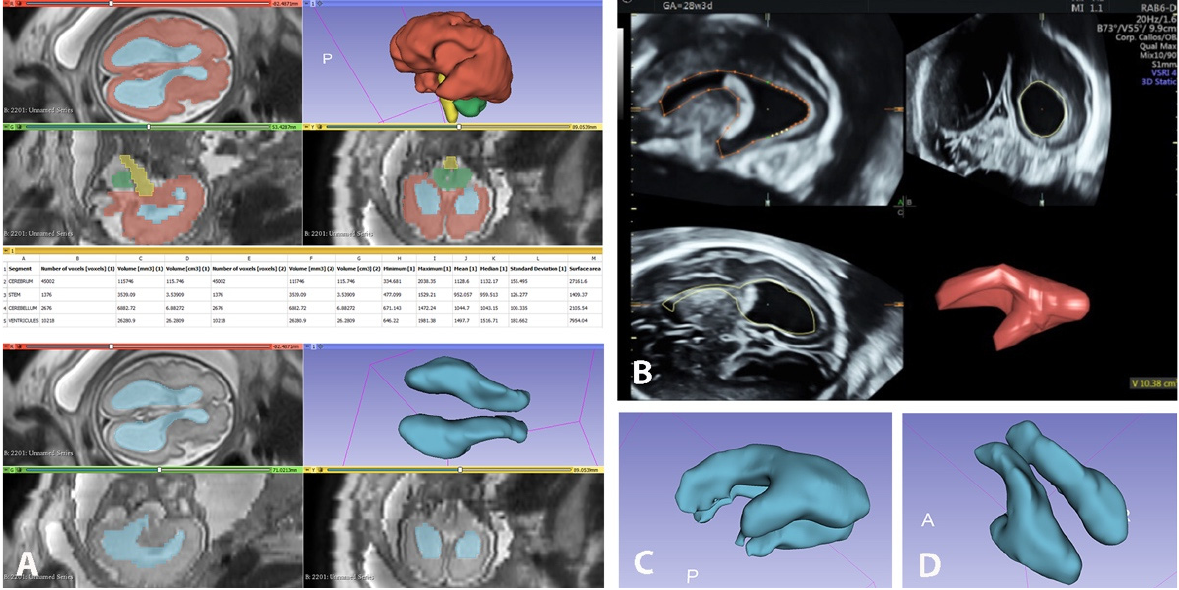
Figure 2. Computed volume segmentations with 3D-Slicer and VOCAL. Fetal brain and ventricle volume calculations using 3D-Slicer ( A ). Ventricular volume segmentation using 3D US VOCAL technique ( B ). Segmented ventricular volumetric reconstructions in lateral and oblique projection of moderate VM ( C , D ).